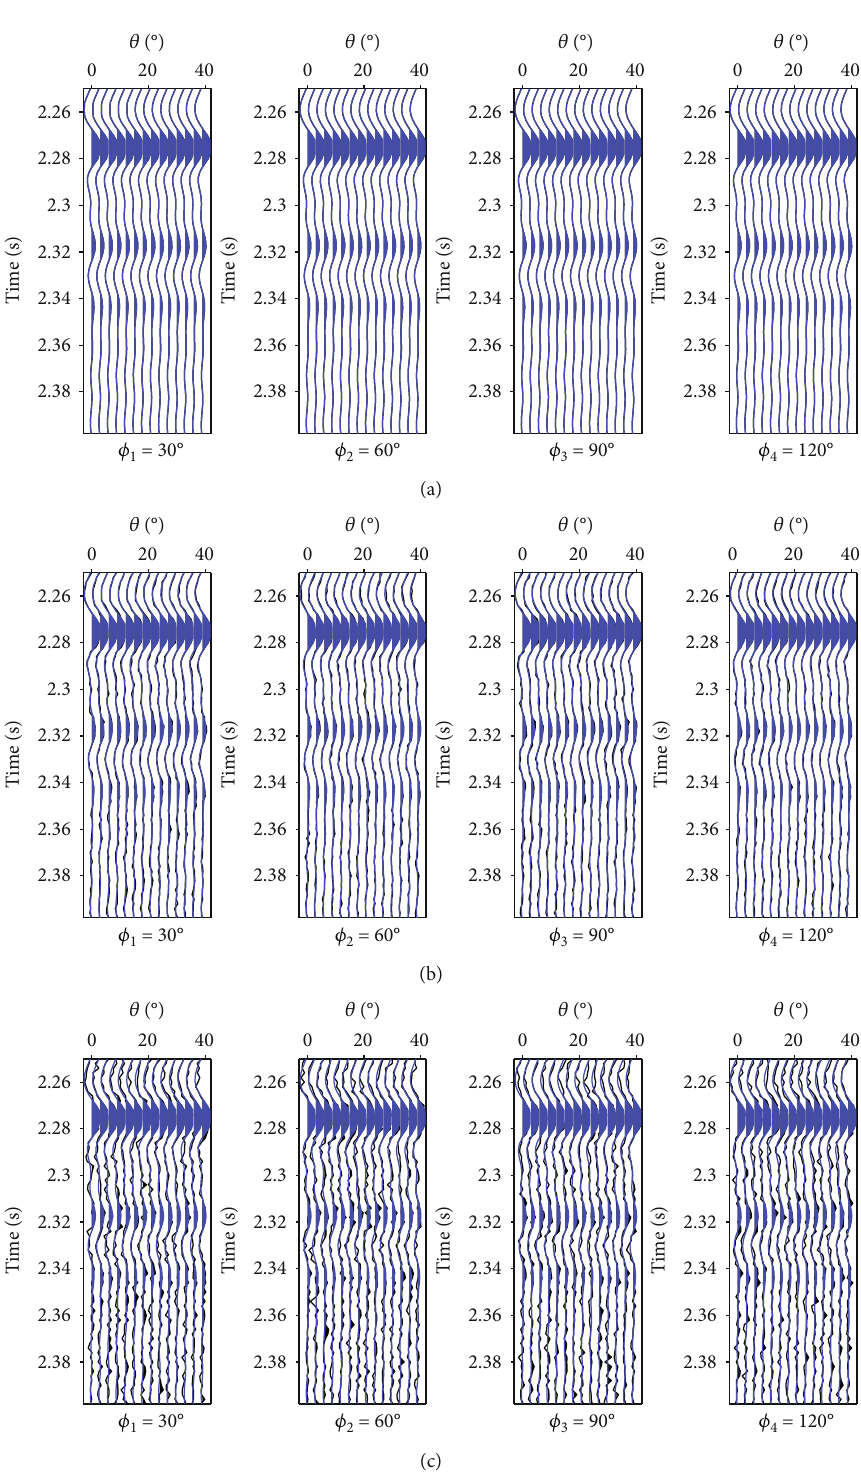
Figure 5: Comparison between synthetic (blue) and initial (black) gathers using the estimated model parameters with di ff erent SNRs, where (a) is noise-free, (b) is 5, and (c) is